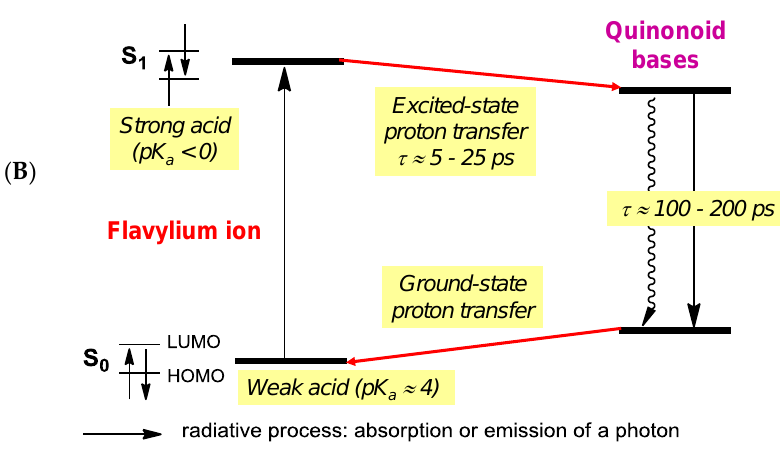
Figure 16. ( A ) Frontier MOs of the flavylium ion of cyanidin (from reference [55]) and its most representative mesomeric forms in the ground state (left) and first excited state (right). ( B ) The fate of free anthocyanins in the excited state (from references [54,56]).